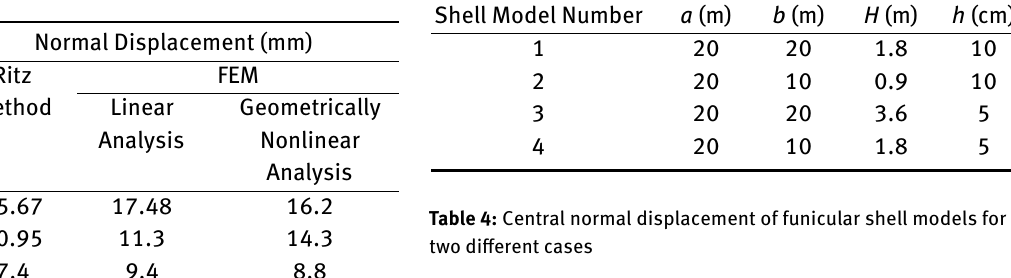
Table 1: Normal displacement at the center of four funicular shell models under a uniformly distributed load of 85 kPa Shell